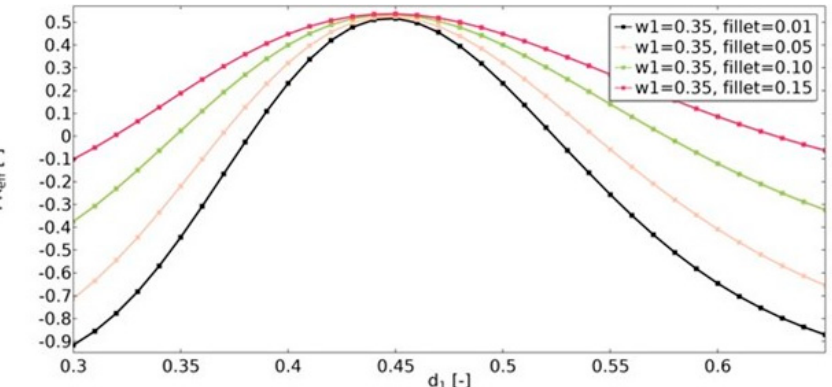
Figure 16. The influence of fillet radius on the value of effective Poisson’s ratio for w 1 = 0.35.